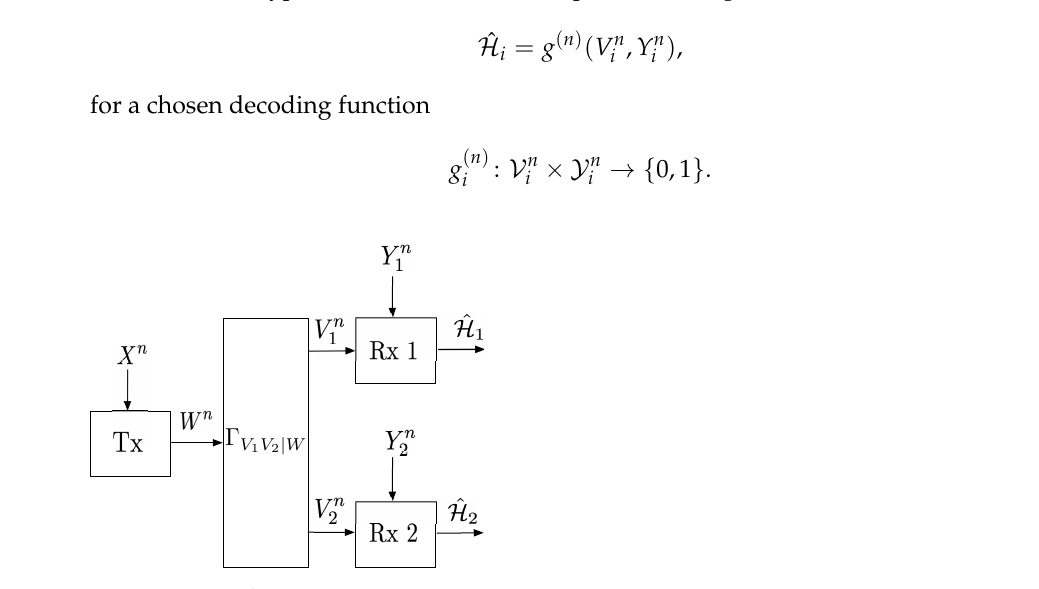
Figure 1. Hypothesis testing over a noisy